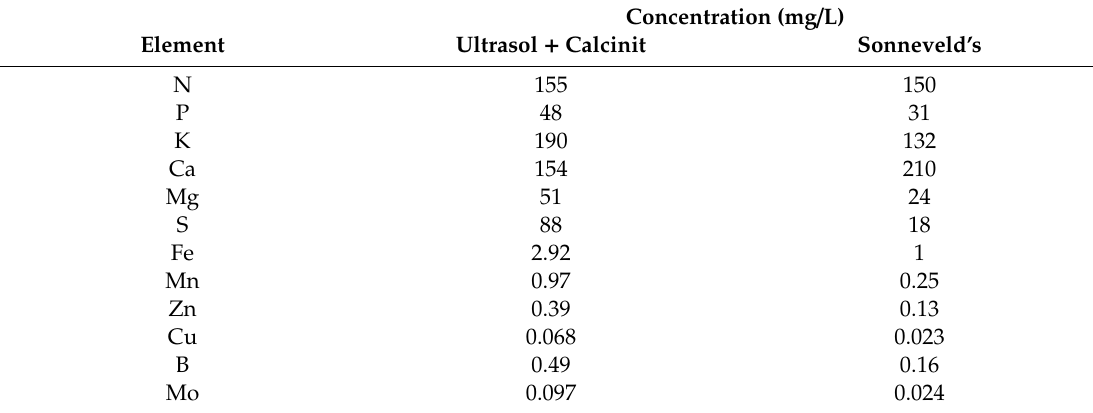
Table 3. Nutrient concentration (mg / L) of two fertilizer solutions. This lettuce study used a combination of Ultrasol + Calcinit and is compared to the Sonneveld’s solution as a reference used by Cornell Controlled Environment Agriculture program in other